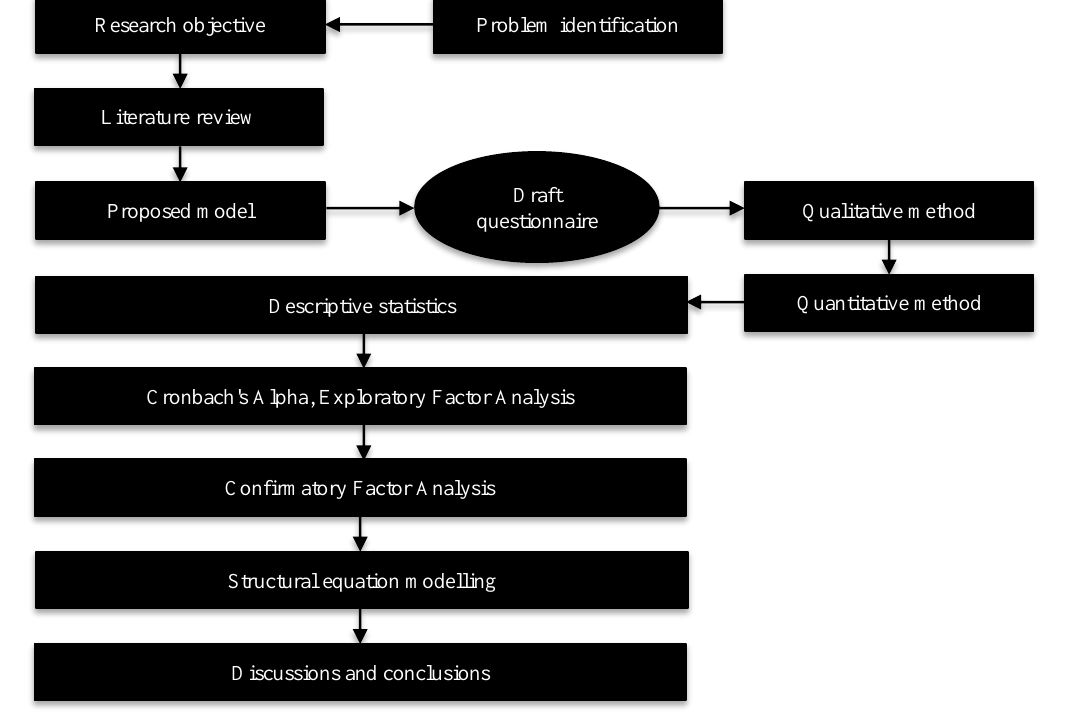
Figure 2. Flowchart of the